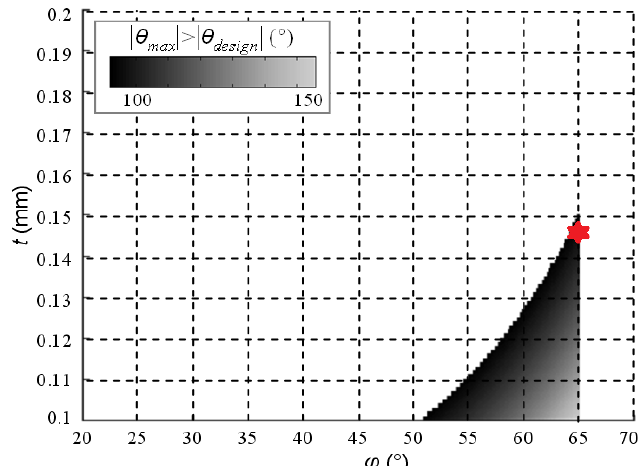
| ≥ | θ | = 100 ◦ (aluminum max design